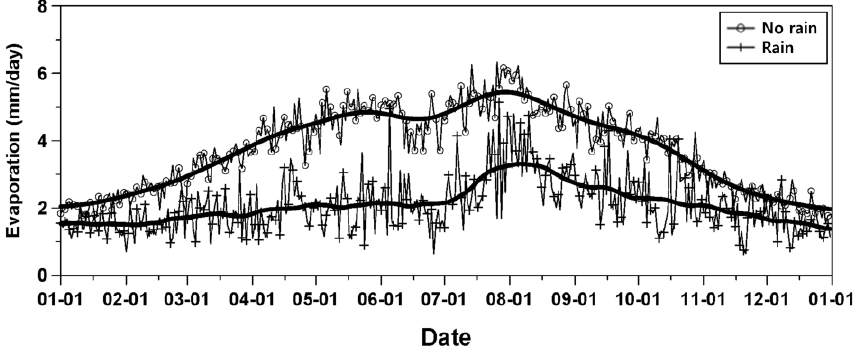
Figure 7. Interannual variation of the daily mean evaporation data depending on the condition of rainfall occurrence, derived with the observed daily pan evaporation data from 1977 to 1990 at the Seongsan Meteorological Station.